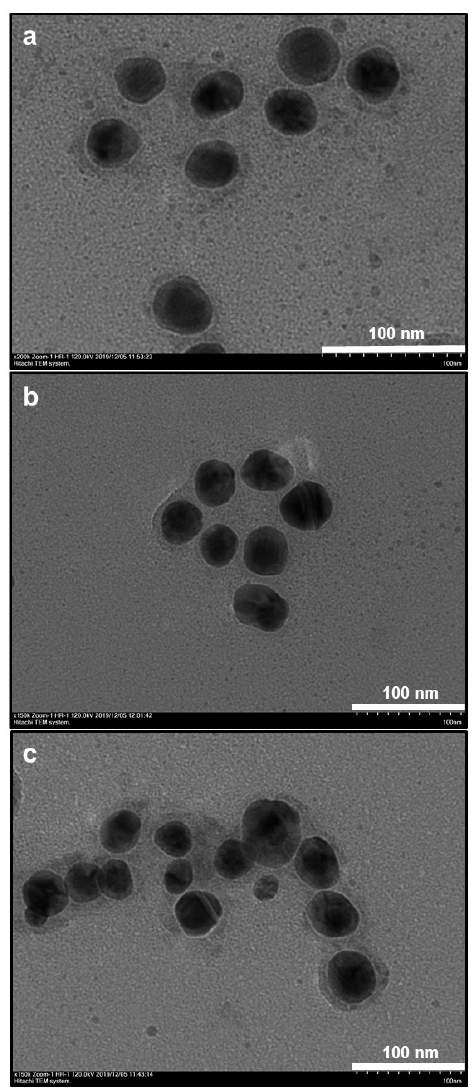
Figure 3. E ff ect of PDOP polymerization time (i.e., PDOP thickness) on core–shell NPs Figure 3. Effect of PDOP polymerization time (i.e., PDOP thickness) on core–shell NPs morphology morphology for 30 min of silver reduction time. TEM images (( a ): for 30 min of silver reduction time. TEM images (( a ): AuNP@30PDOP@30AgNP, ( b ):